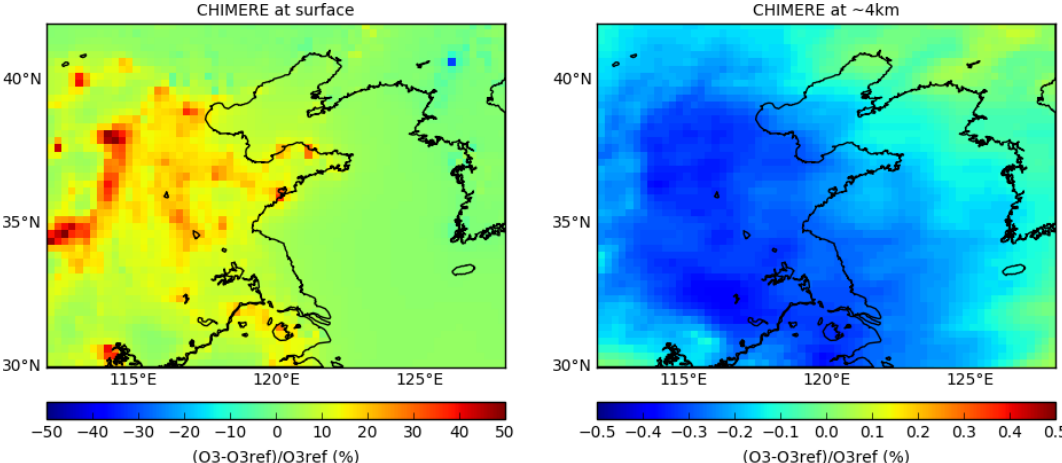
Figure 10. Relative difference (%) at the surface (left) and at ∼ 4km (right) between a CHIMERE simulation based on corrected NO x and SO 2 emissions using OMI satellite data and a CHIMERE simulation based on the EDGAR-HTAP-v2.2 2010 emission inventory.